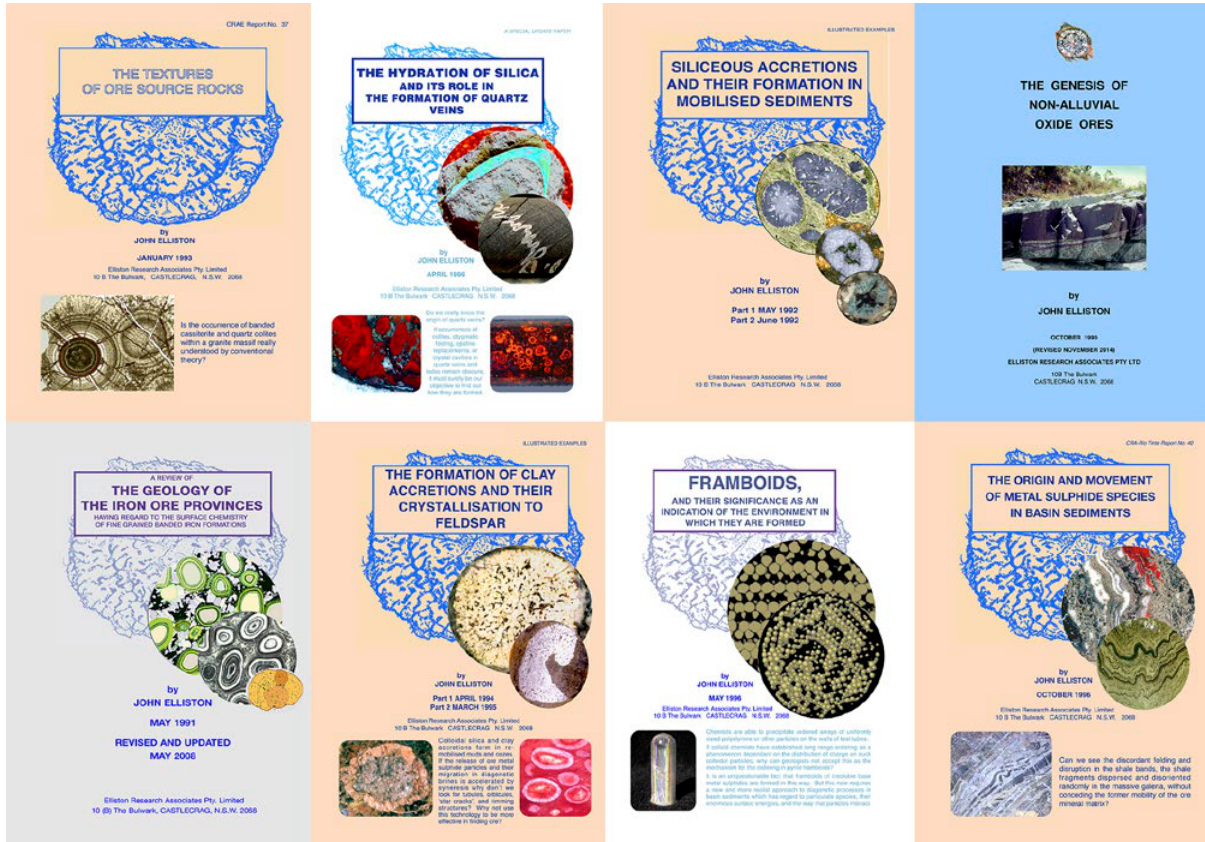
Figure 12. Some of the more significant progress reports detail the features of ore source rocks, the aqueous chemistry of silica, the forma- tion of siliceous accretions, the origin of non- alluvial oxide ores, the geology of the iron ore provinces, the formation and crystallisation of clay accretions, the formation of framboids and the origin of metal sulphide species that accumulate as mineable